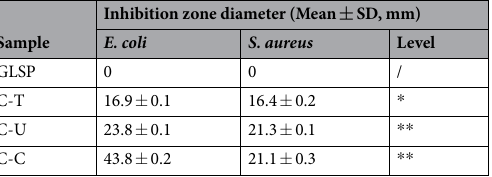
Table 2. Inhibition zone obtained using agar plates method against E. coli and S. aureus . * Very sensitive, ** extremely sensitive.